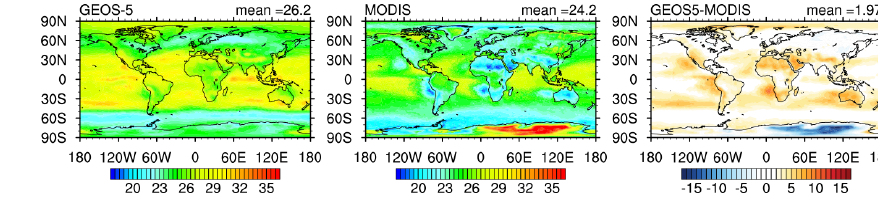
Figure 13. Ice cloud effective radius (µm) from GEOS-5 (NEW run) using COSP and from the MODIS retrieval.